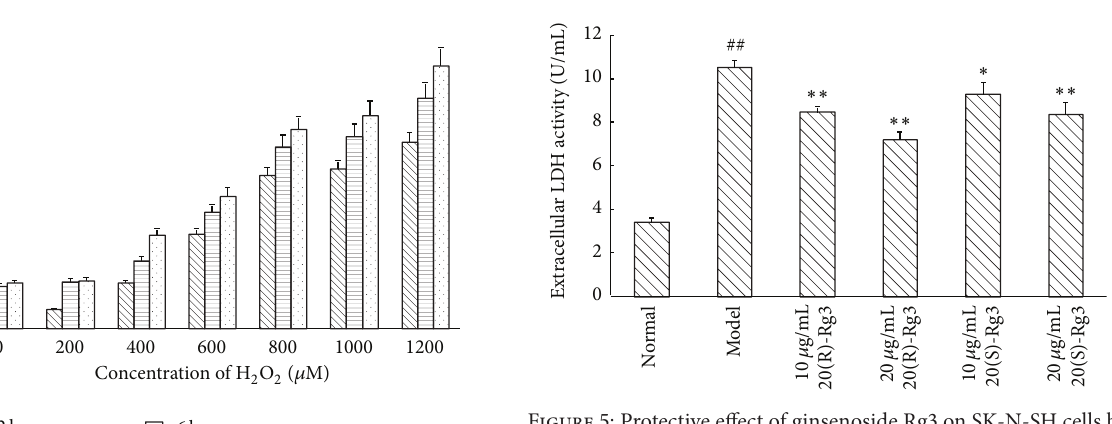
Figure 5: Protective effect of ginsenoside Rg3 on SK-N-SH cells by extracellular LDH assay. ## 𝑃 < 0.01 versus normal group, ∗ 𝑃 < 0.05 , and ∗∗ 𝑃 < 0.01 versus model group.